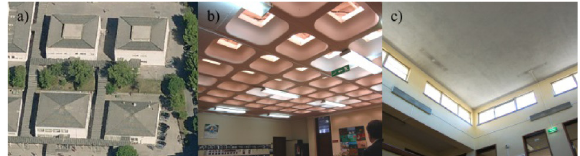
Fig. 3. Secondary school from sub-typology C: a) aerial view of two different roof solutions; b) interior view of the central circulation area illuminated by skylights; c) lateral windows